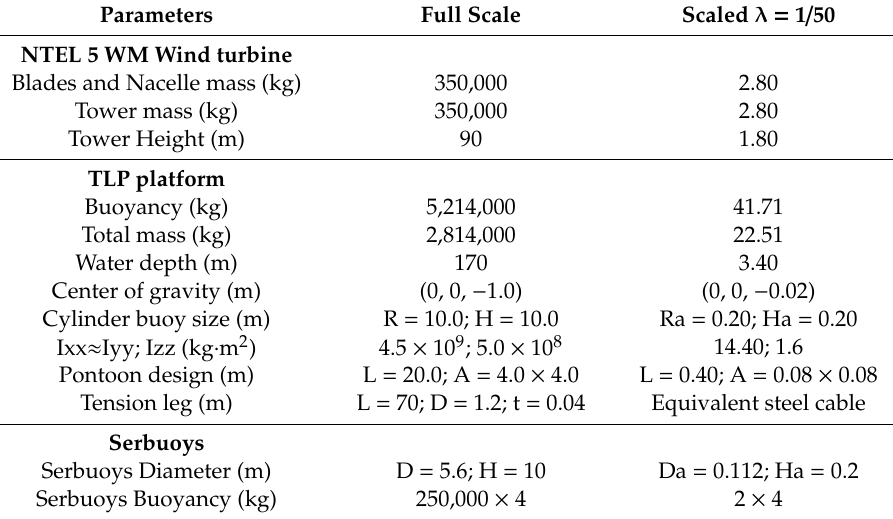
Figure 4. Scale model test system. Table 1. Main design parameters of the Serbuoys-TLP model.